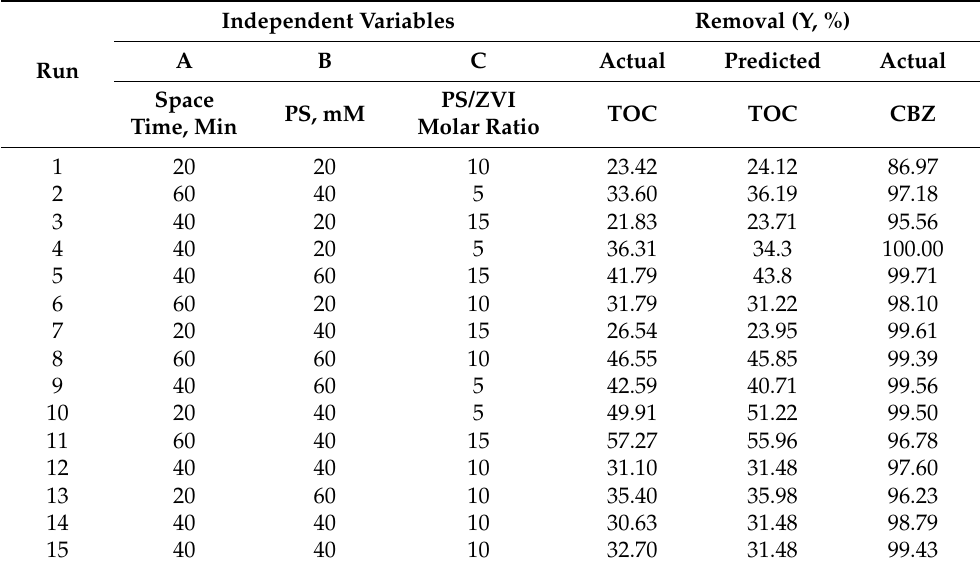
Table 1. Predicted and actual removal efficiencies for the continuous flow UV/PS/ZVI process. Independent Variables Removal (Y, Run